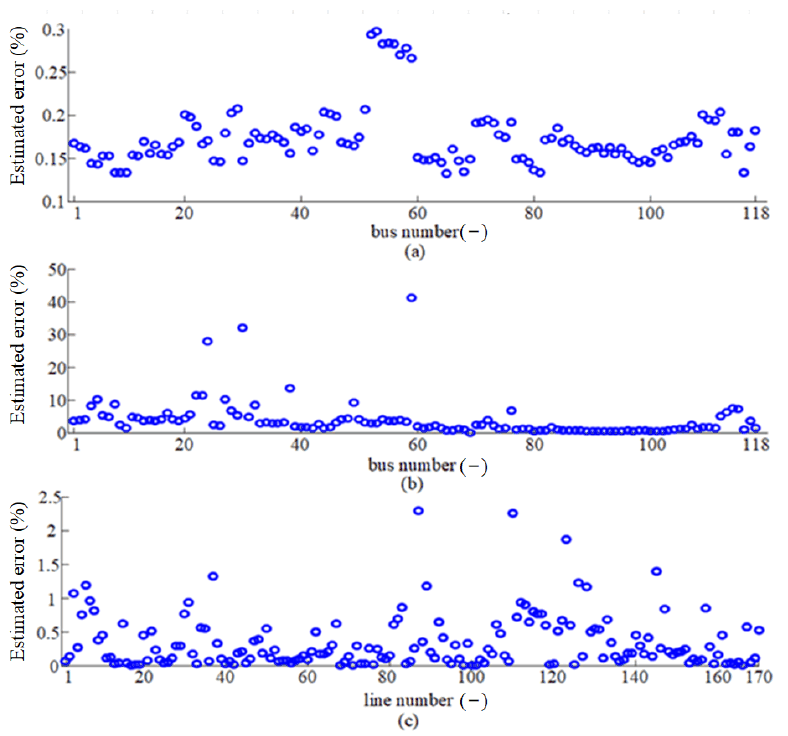
Figure 8. Resistance and line temperature error of the IEEE 118-bus system. ( a ) Voltage amplitude error, ( b ) phase angle error, ( c ) line temperature error.